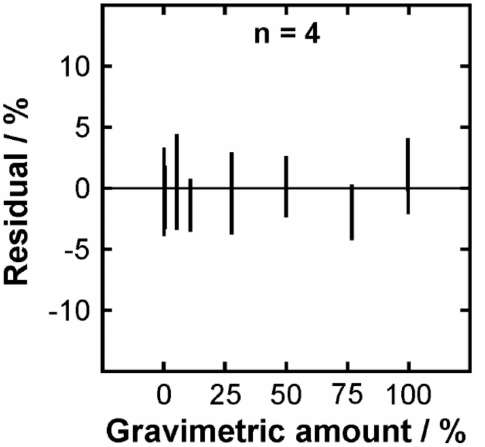
Figure 8. Residual ranges of the leave-one-out cross-validation (LOOCV) for the PLSR evaluation employing four